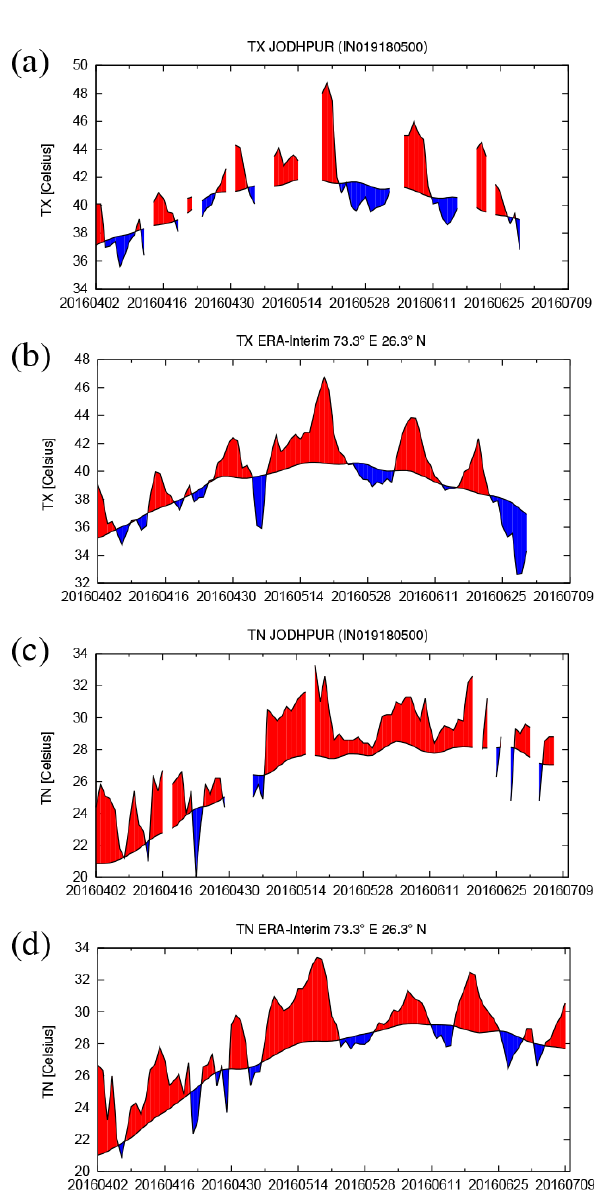
Figure 5. April–June daily maximum temperature time series from (a) GHCN-D v3.22 observations at Jodhpur, the closest station to Phalodi with publicly available data; and (b) ERA-Interim inter- polated at the coordinates of Jodhpur ( ◦ C). (c, d) Same for the daily minimum temperature. Departures from each dataset’s clima- tology (1981–2010) are shown in red (positive) and blue (negative). Days with missing data are left